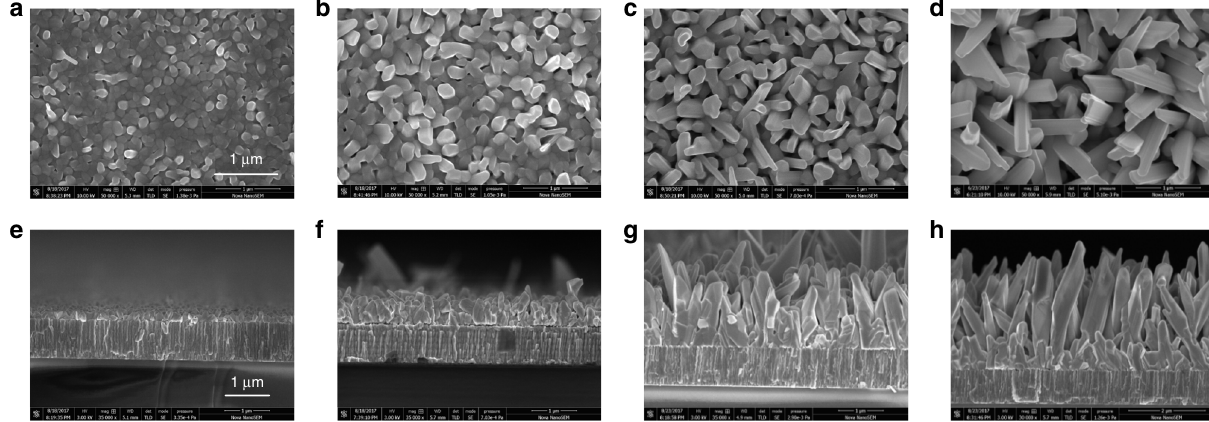
Fig. 2 Morphology evolution of Sb 2 Se 3 : from thin fi lm to nanorod array. a – d Top-view SEM images of Sb 2 Se 3 with different deposition times, a 60 s, b 120 s, c 160 s, and d 180 s. e – h The corresponding cross-sectional images of Sb 2 Se 3 with different deposition time, e 60 s, f 120 s, g 160 s, and h 180 s. The scale bar for a – h is 1 μ m